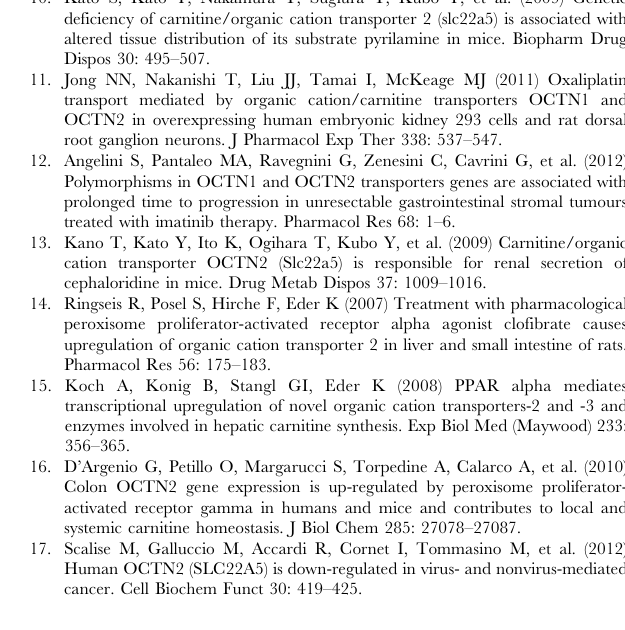
Figure S2 Methylation profiles around the transcriptional start site of OCTN2 in QBC-939 cells. DNA was extracted and subjected to bisulfite modification. Bisulfite modified DNA was amplified by BSP and sequenced as described under Materials and methods . Pointed star represents methylated CpG sites. (TIF) Figure S3 Methylation profiles around the transcriptional start site of OCTN2 in U251 cells. DNA was extracted and subjected to bisulfite modification. Bisulfite modified DNA was amplified by BSP and sequenced as described under Materials and methods . Pointed star represents methylated CpG sites. (TIF) Figure S4 Transcription factor binding site analysis of the promoter region of OCTN2 by TFsearch software. To reveal the mechanism by where methylated CpG sites inhibit OCTN2 transcription, we mapped the putative consensus sequences for the transcription factors. CpG sites are on the red lines. Putative consensus sequences are indicated by dotted lines. (TIF) Table S1 Primers for Quantitative RT-PCR, MSP and BSP. Table S2 Primers for the construction of luciferase reporter